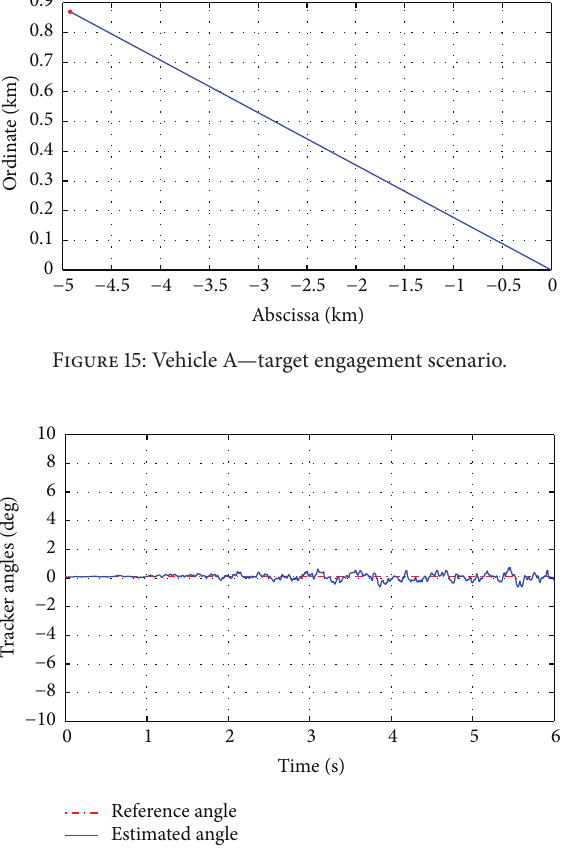
Figure 16: Angle trajectories for vehicle A